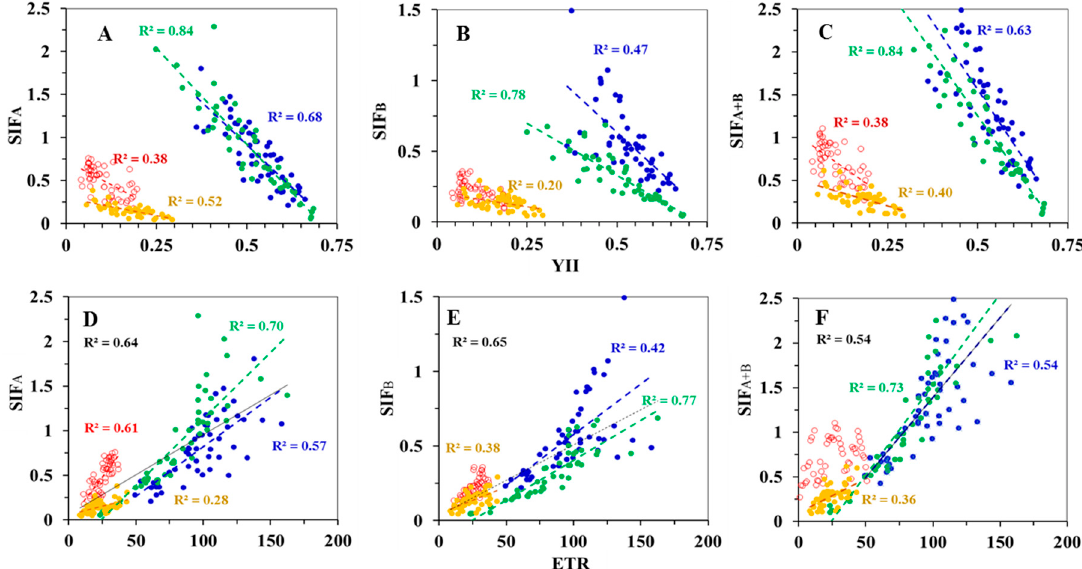
Figure 7. Correlations between diurnal observations (i.e., observations collected in the 8:45–16:45 timeframe) of canopy solar induced fluorescence (SIF) and leaf-level yield to PSII (YII, A–C ), and between SIF and electron transport rate (ETR, D–F ). The relationships are evaluated using measurements from three consecutive clear days selected in each growth stage (i.e., young (n = 51, blue), mature (n = 49, green), senescing: initial (n = 51, red), and advanced (n = 52, yellow). The linear coefficients of determination (R 2 ) are listed in colors according to growth stage. The overall coefficient of determination (R 2 , n = 203) of the relationship using data from all stages is listed in black, only when the trends were statistically significant (p < 0.01). Refer for units to Table 1.